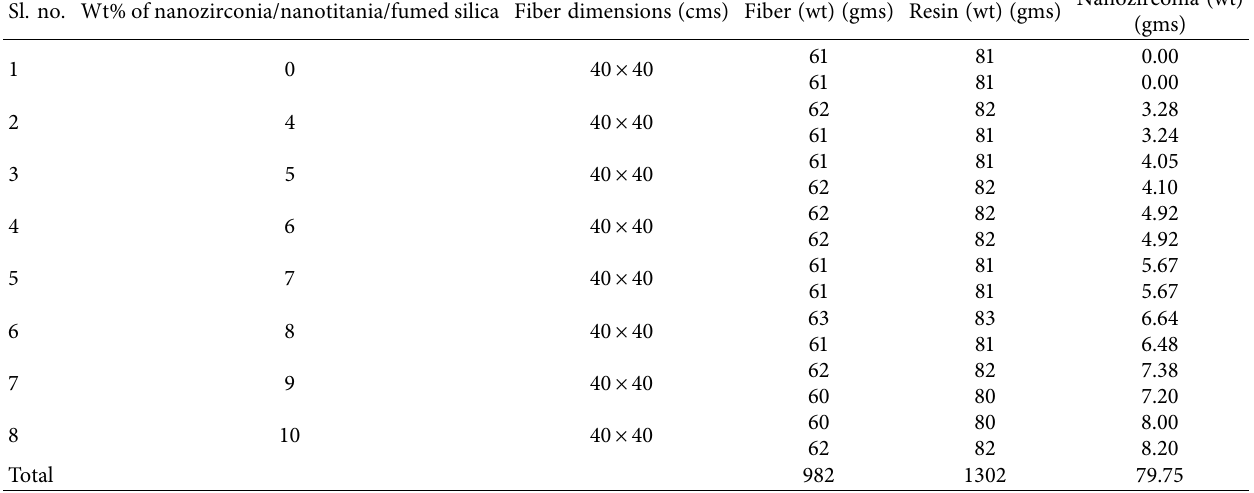
Table 3: Details of filler ratio, fabric dimensions, and resin and fabric weights used in the prepreg preparation.